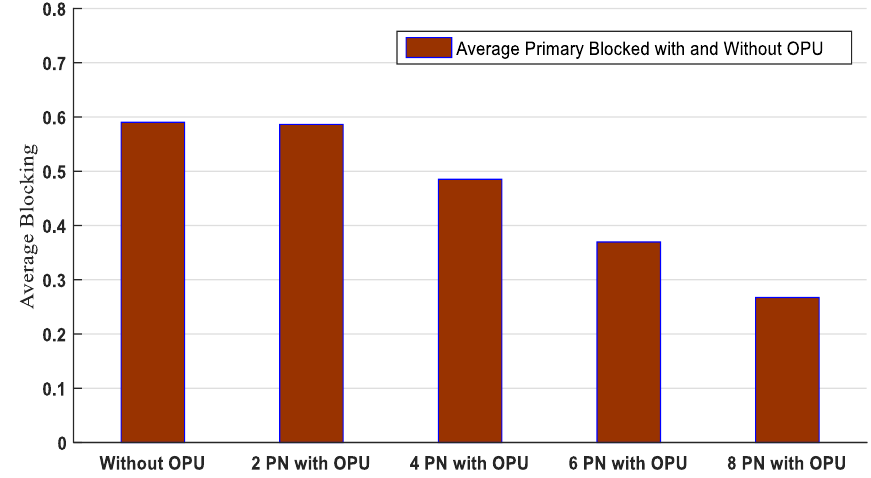
Figure 9. Average primary blocked with and without OPUs